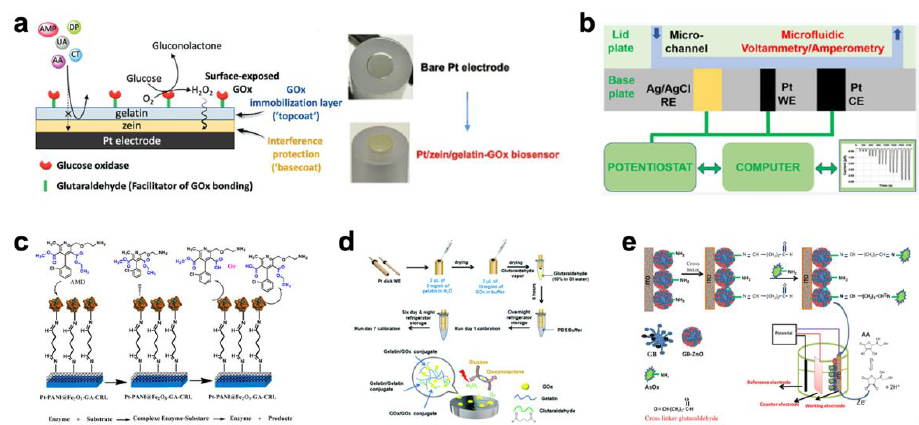
Figure 1. Biosensors for medical diagnosis with gelatin matrix. ( a ) Pt/zein/gelatin-GOx biosensors- design and fabrication [33] (copyright (2021) Wiley-VCH GmbH); ( b ) a reusable DIY three-electrode base plate for microfluidic electroanalysis and biosensing [34] (copyright (2021) American Chemical Society); ( c ) schematic of the biosensor elaboration using PANI@Fe 2 O 3 [35] (Copyright (2018) by the authors); ( d ) the gelatin/GOx-Pt glucose biosensor fabrication procedure and possible gelatin–GOx conjugations during biocatalyst immobilization [33] (copyright (2020) The Royal Society of Chemistry 2020); ( e ) proposed electrochemical reaction and synthesis of AsOx/GB-ZnO/ITO bioelectrode [37] (copyright (2015) Wiley-VCH Verlag GmbH & Co. KGaA,